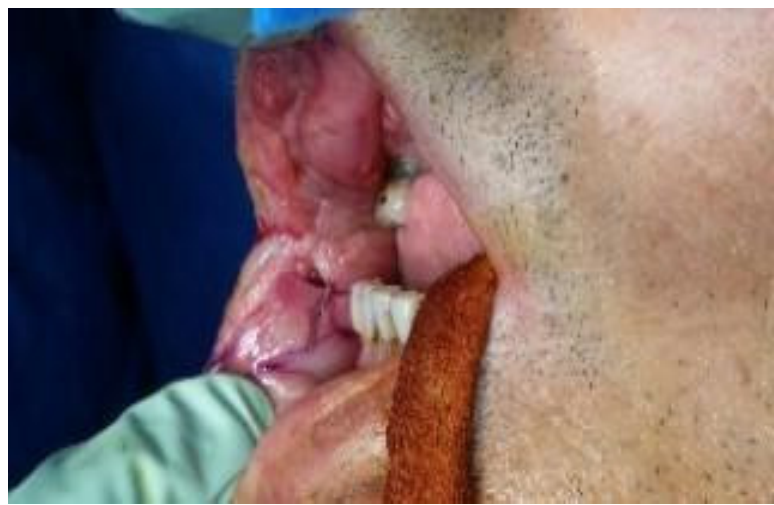
Figure 5. Case 2: Squamous cell carcinoma of the right commissure extending to the upper and lower lips.